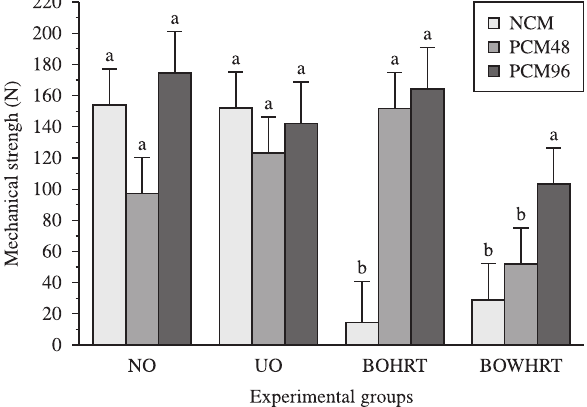
Figure 3. Mean mechanical strength of newly formed bone. NCM: native collagen matrix; PCM48: polyanionic collagen matrix submitted to alkaline treatment for 48 hours; PCM96: polyanionic collagen matrix submitted to alkaline treatment for 96 hours; NO: non-ovariectomized animals; UO: unilaterally ovariectomized animals; BOWHRT: bilaterally ovariectomized animals not submitted to hormone replacement therapy; BOHRT: bilaterally ovariectomized animals submitted to hormone replacement therapy. p < 0.05 indicates statistical